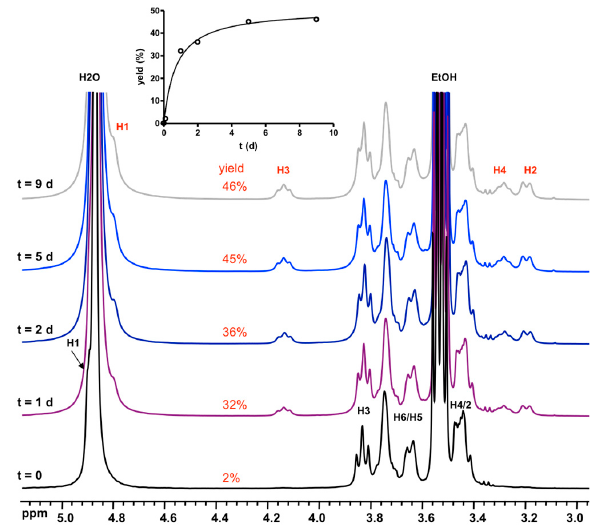
Figure 3. Evolution of 1 H NMR spectra of the synthesis medium in the system 1 α -CD:6 TEOS:6 KOH:300 D 2 O with time, showing the growth of signals of D6R@ α -CD. Inset: plot of the progressive increase of the yield with time measured from the signal of H3 at ca. 4.1 ppm.